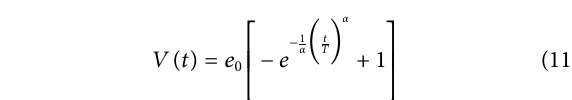
FIGURE 3 | Evolution of V ( t ) with α (cid:2) 0 .